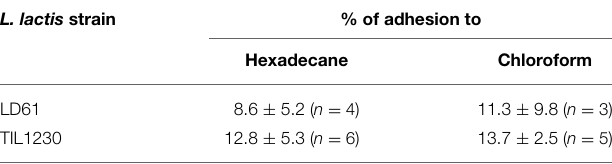
TABLE 2 | Results of the microbial adhesion to solvents (MATS) method * .